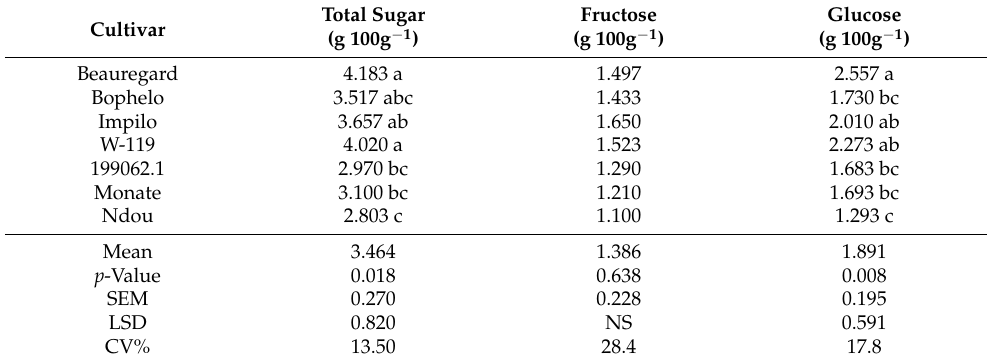
Table 2. Total sugar, fructose, and glucose content of sweet potato cultivars with varying flesh colors.